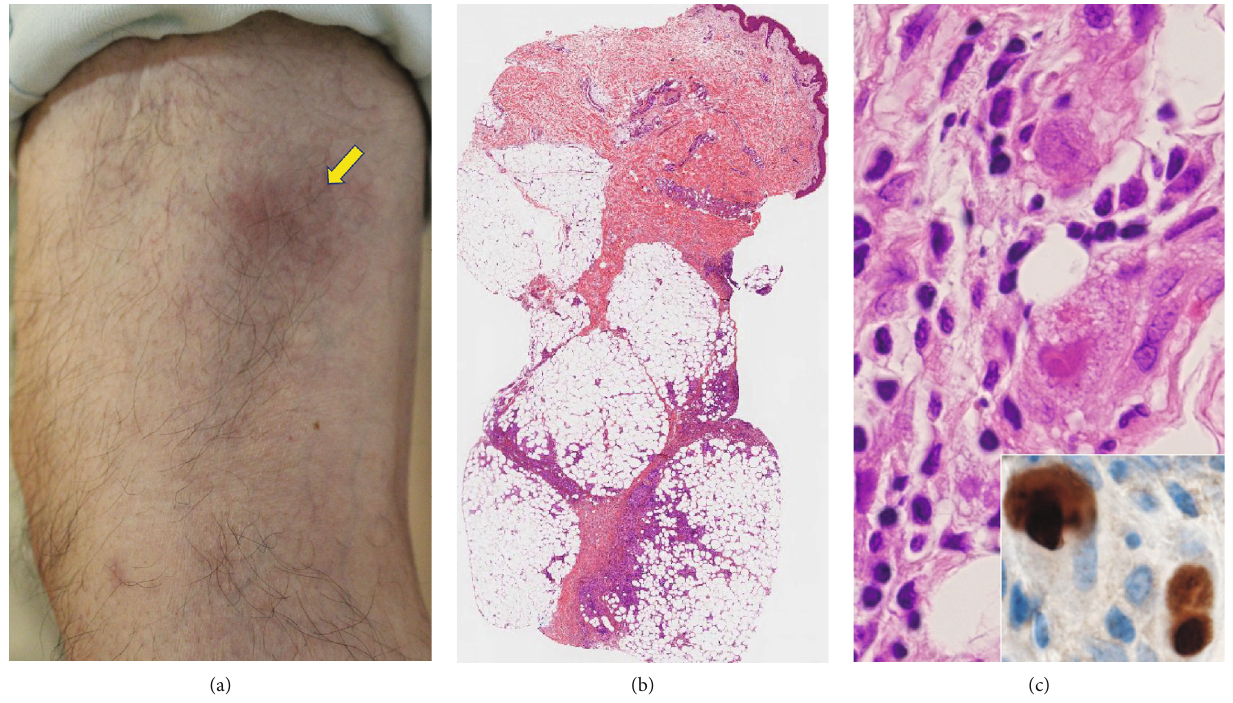
Figure 2: A subcutaneous nodule without ulceration ((a) gross appearance; (b) H&E, low-powered view; (c) H&E, high-powered view of the subcutaneous tissue, inset: immunostaining for CMV antigens). Subcutaneous nodularity with mild reddening is observed on the lower thigh near the original ulcer by pyoderma gangrenosum (arrow, (a)). A low-powered view of the second biopsy specimen demonstrates subcutaneous septolobular panniculitis (b). Endothelial cells and perivascular stromal cells with enlarged nuclei reveal intranuclear and cytoplasmic inclusions (c). Immunostaining for CMV antigens is clearly positive